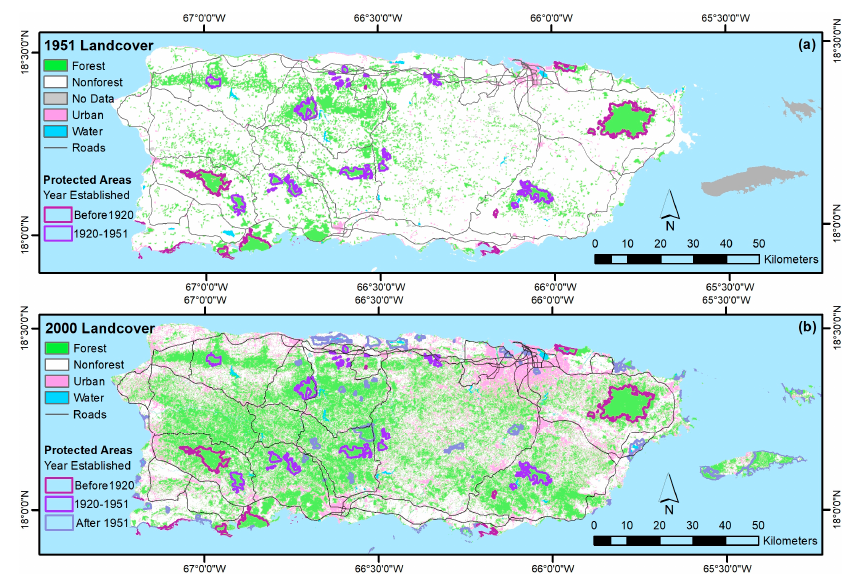
Figure 3. Puerto Rico and two of its outying islands, showing ( a ) forest cover in the year 1951 and ( b ) forest cover in the year 2000, with both showing protected areas [70,71] and their date of establishment. Table 2. Correlation coefficients (Correl. Coef.) and mean absolute error (MAE), in the same units as the forest characteristics, for observed vs. predicted plot-level values for mapping models of forest structure, tree species characteristics, and functional traits, ordered by decreasing correlation coefficient for Cubist models.